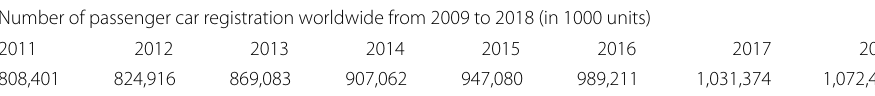
Number of passenger car registration worldwide from 2009 to 2018 (in 1000